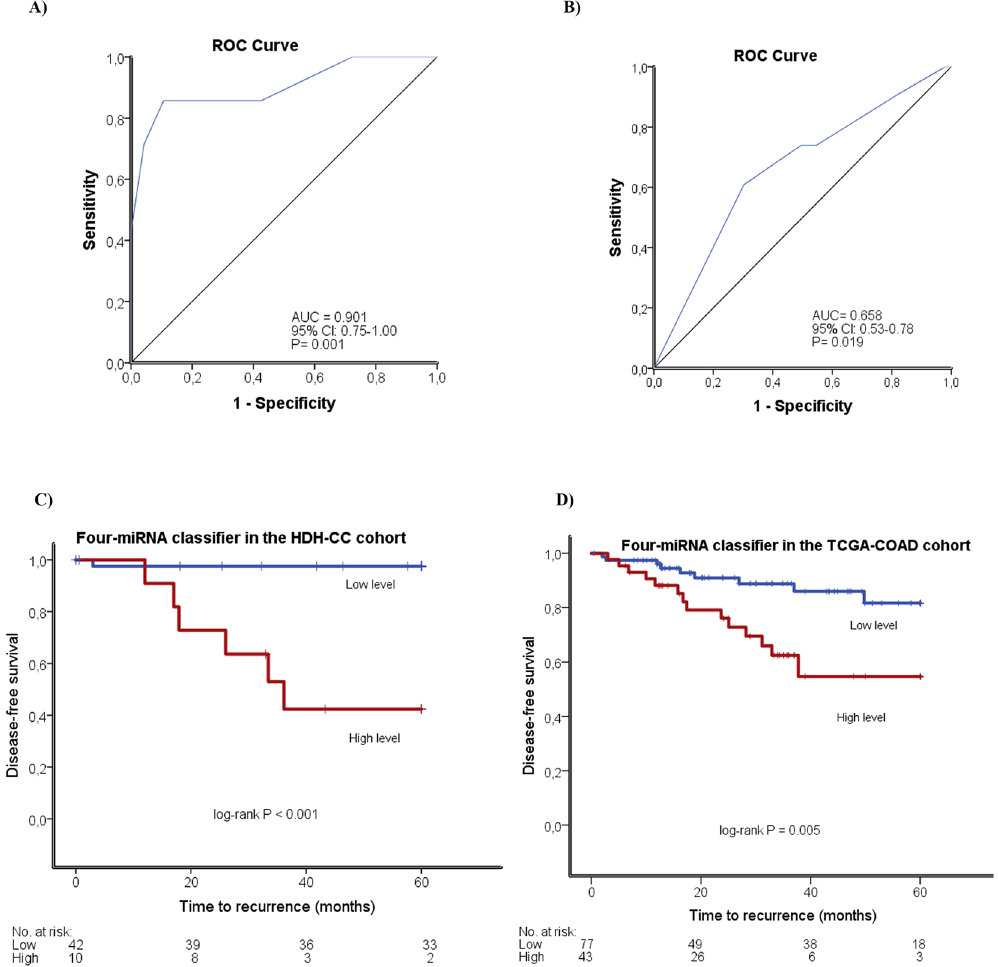
Figure 1. ROC curve analyses in the HDH-CC cohort ( A ) and in the TCGA-COAD cohort ( B ). Kaplan-Meier plots for the four-miRNA classifier in the HDH-CC cohort ( C ) and in the TCGA-COAD cohort ( D